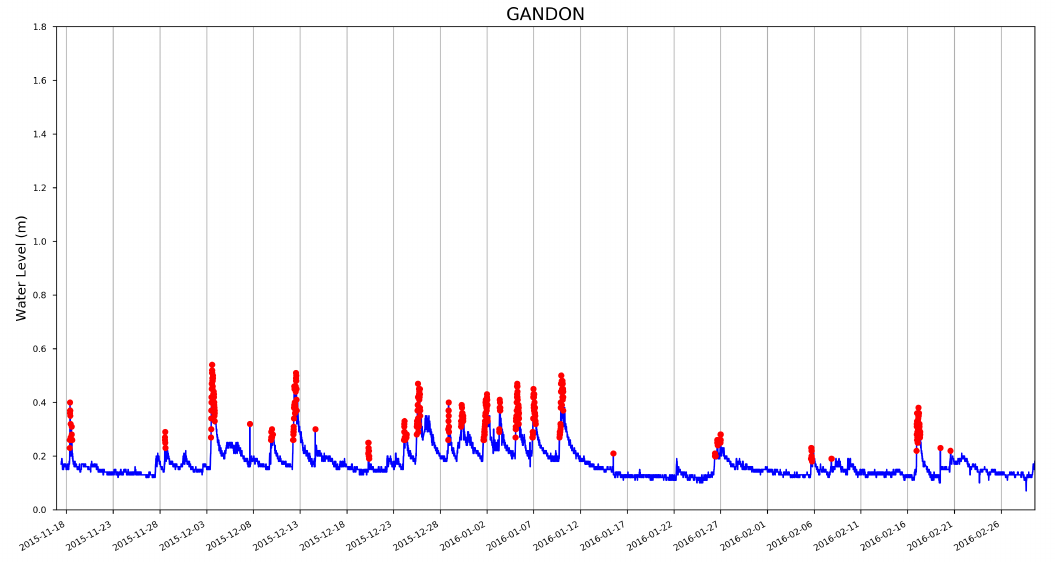
Figure 9. Anomaly detection results (first 10,000 measurements) using MoPBAS at Gandon